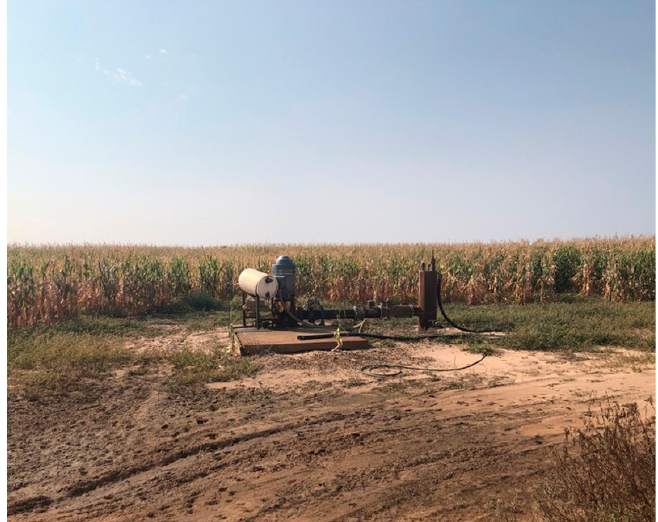
Figure 2. The electric well pump is smaller and has less visual contrast than a windmill, but it lacks deep meaning and does not seem like it belongs (Photo by author).